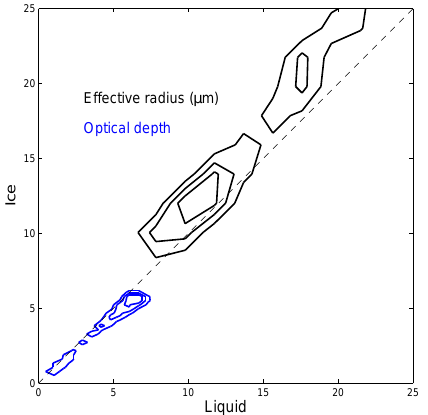
Fig. 11. Linear probability density distributions (contours) for an inter-comparison of retrieved and Microwave Radiometer (MWR) measured LWP. The dashed line is a 1:1 line.